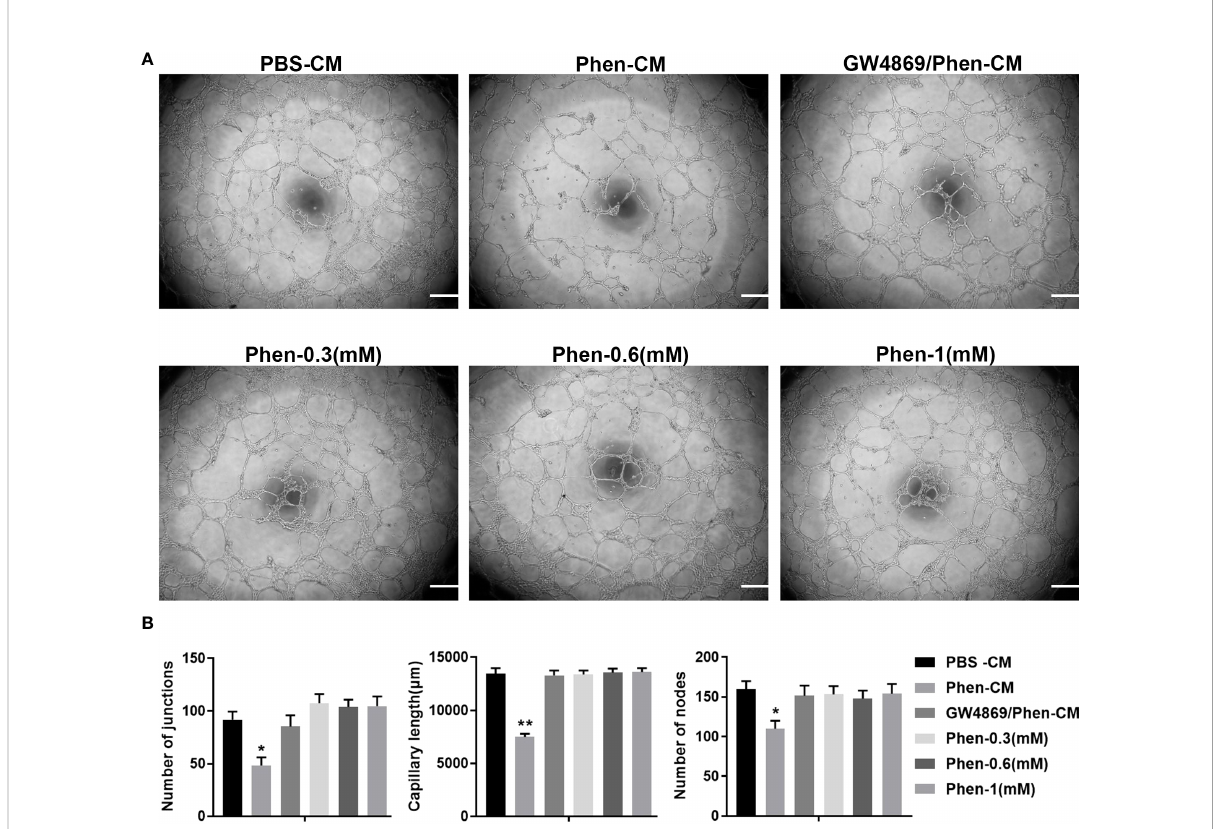
FIGURE 1 The conditioned medium from CAL 27 OSCC cells treated with phenformin inhibits the tube formation of vascular endothelial cells in vitro . (A) Matrigel tube formation assays of HUVECs treated with different conditioned medium (CM) collected from CAL 27 cell cultures: the CM from PBS treatment (PBS-CM), the CM from 1 mM phenformin treatment (Phen-CM) and the CM from 20 m M GW4869 plus 1 mM phenformin treatment (GW4869/Phen-CM) or different concentrations of phenformin: 0.3 mM, 0.6 mM and 1 mM. (B) Quanti fi cation of junctions, capillary length and nodes in the network structures of HUVECs in (A) . All experiments were performed three times, and error bars represent means ± SD; P values are indicated with “ * ” , * indicates P<0.05, ** indicates P<0.01 when comparing Phen-CM group with any other group in panels (B) by Student ’ s t